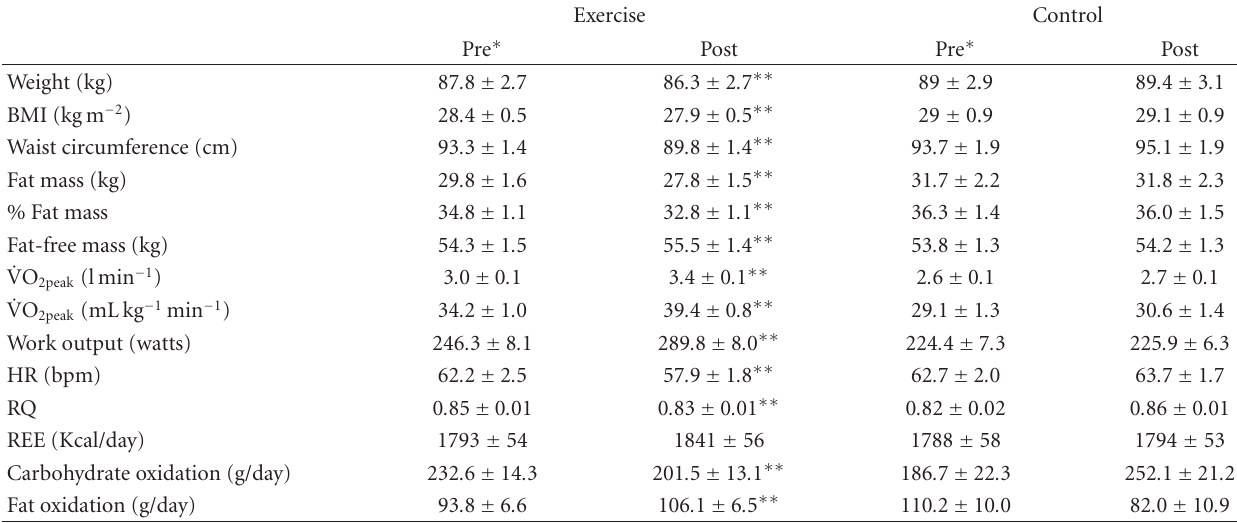
Table 1: Change in body composition, aerobic power, resting heart rate, RQ, resting energy expenditure, carbohydrate, and fat oxidation for the high-intensity intermittent exercise and no exercise control group ( N = 38; mean and standard error). Exercise